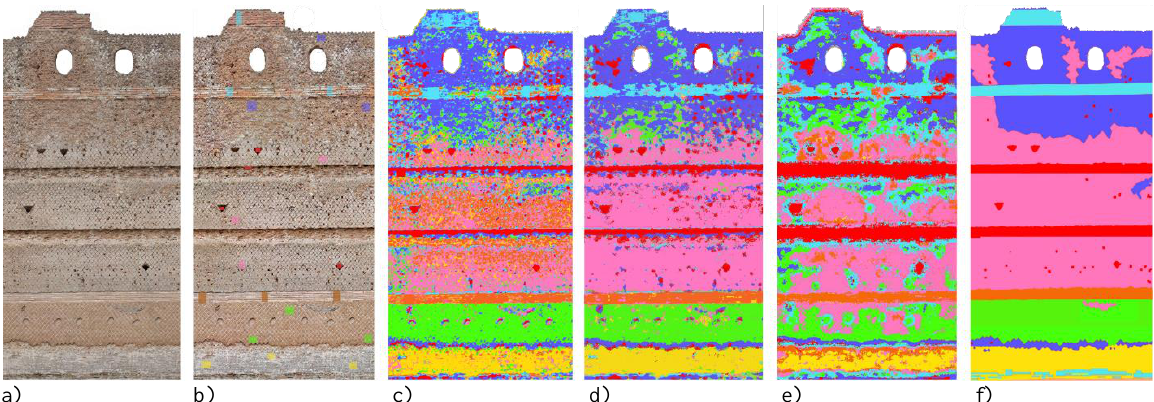
Figure 5: Orthoimage of a portion of Pecile’s wall (4m length x 9m height) exported at 1:20 scale (a), corresponding training samples (b), classification results obtained at different scales. Scale 1:10 (c), scale 1:20 (d) scale 1:50 (e), ground truth